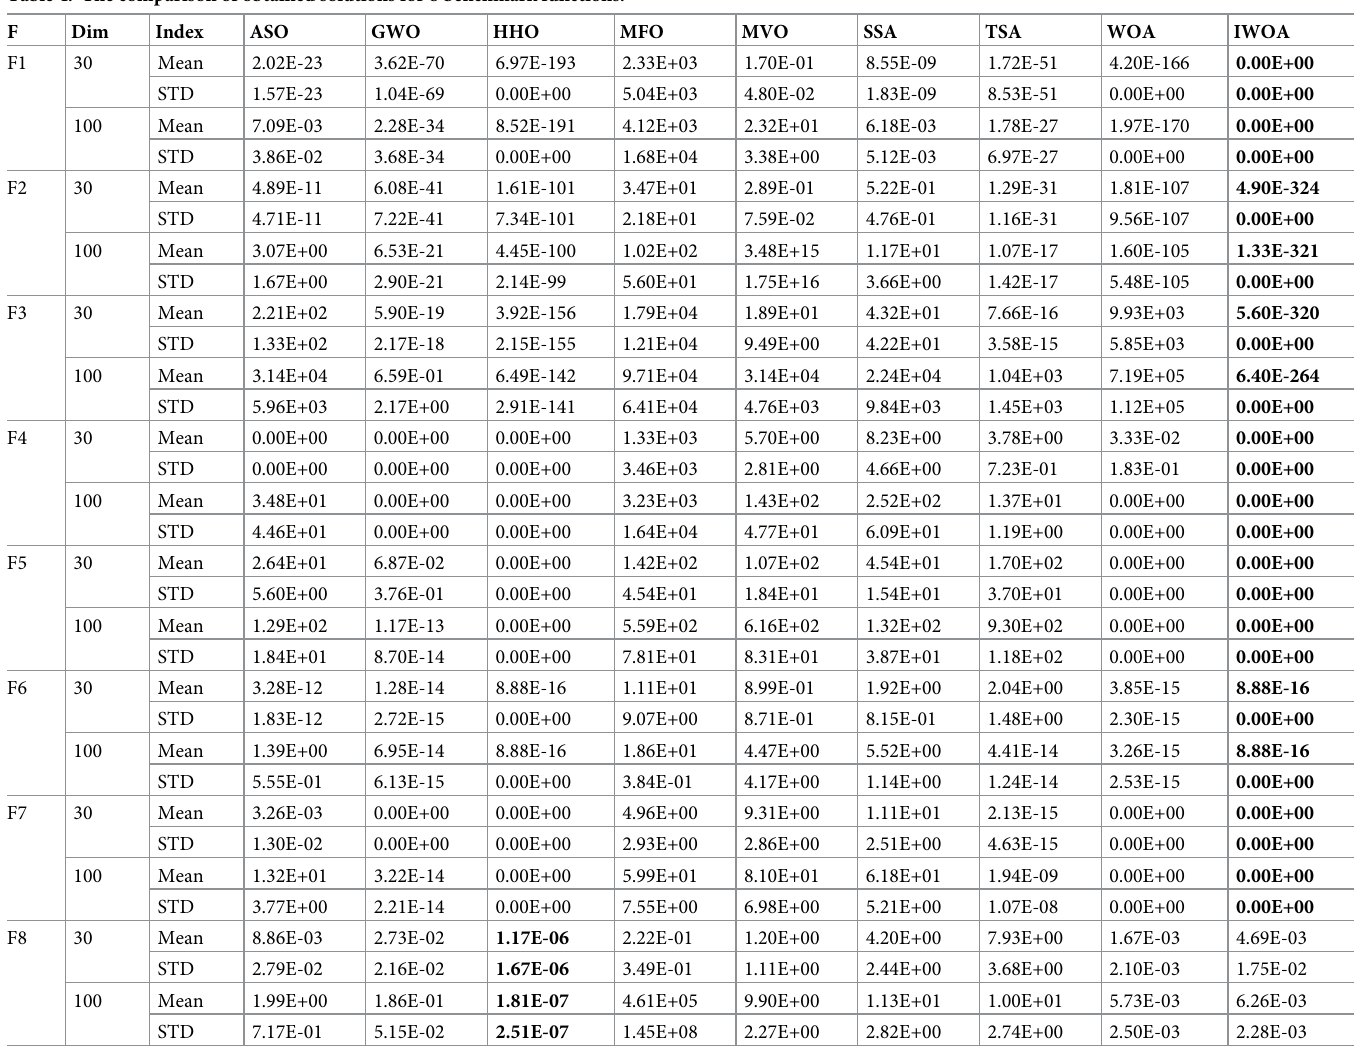
Table 4. The comparison of obtained solutions for 8 benchmark